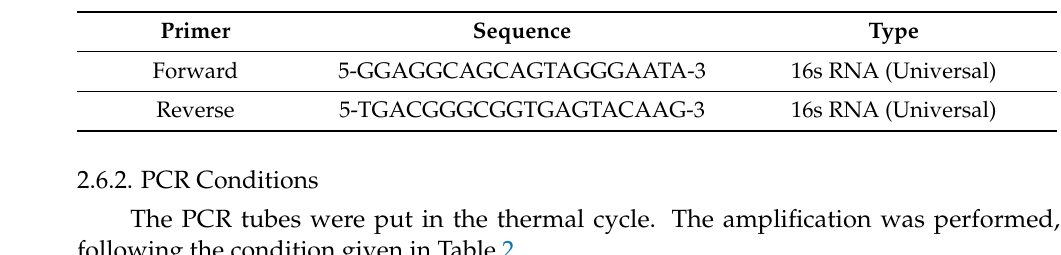
Table 1. Primer name and Sequence.